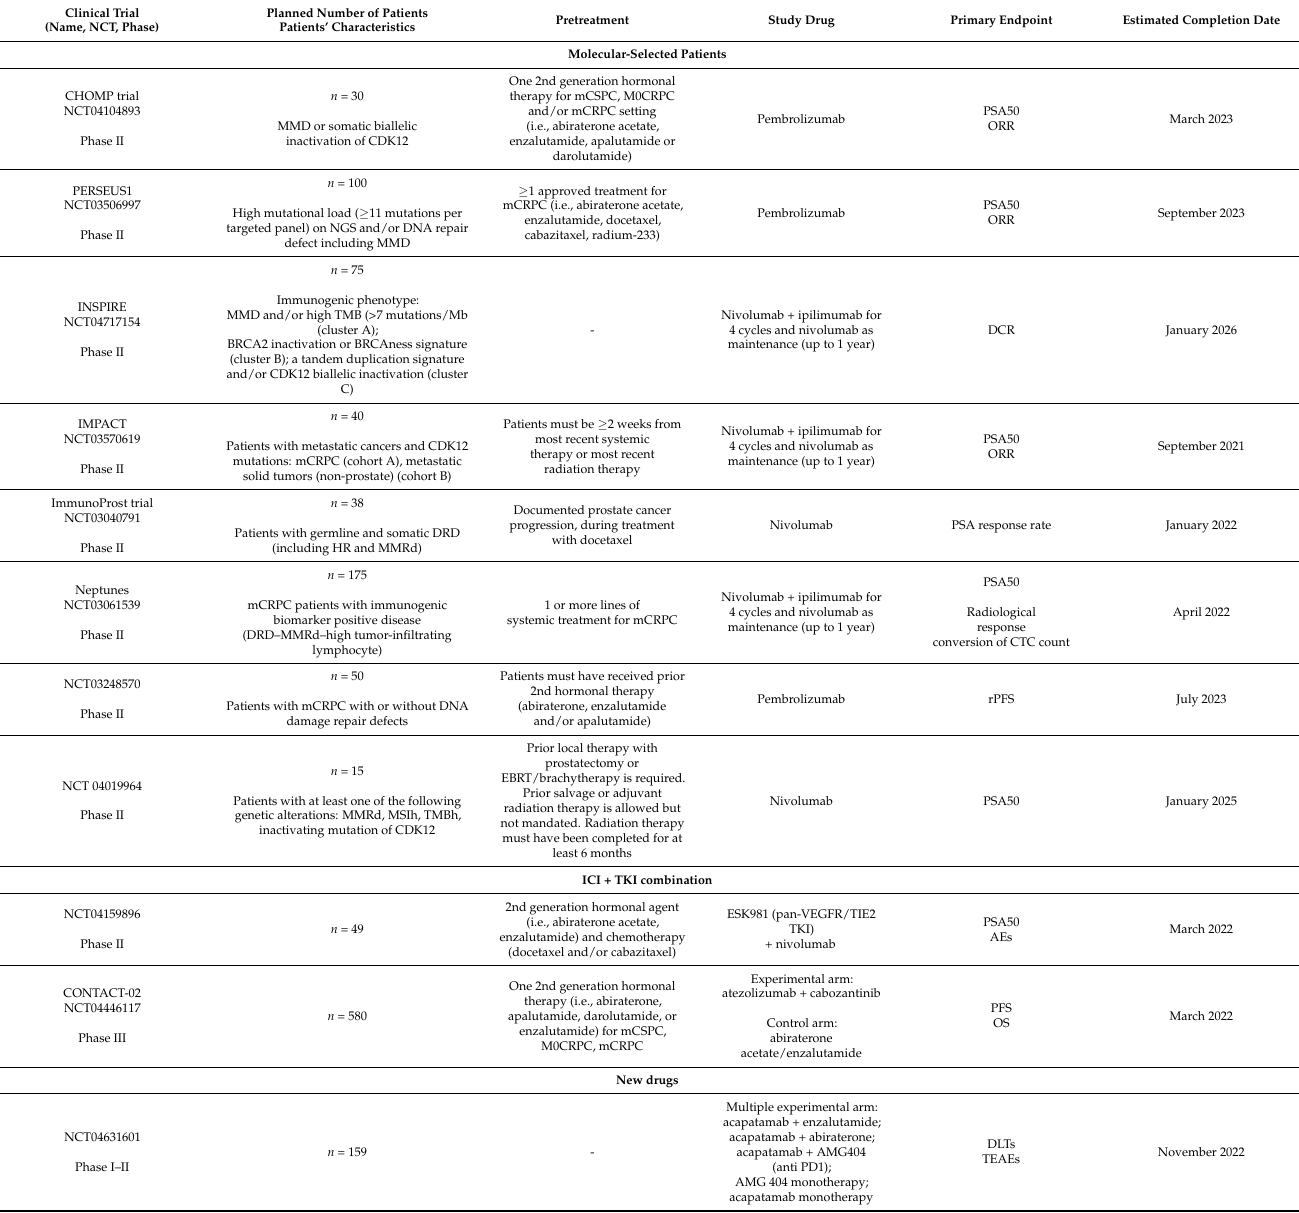
Table 2. Ongoing clinical trials on ICIs in mCRPC